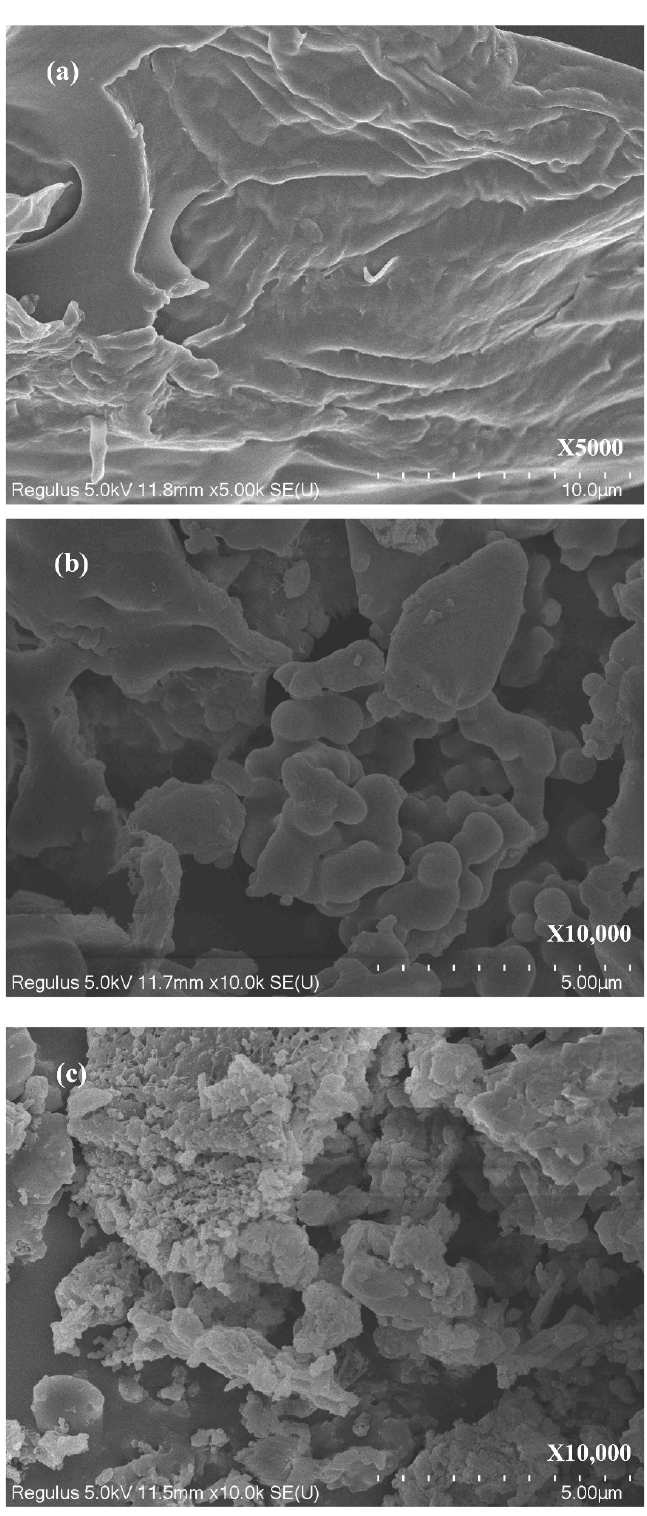
Figure 3. SEM images of PP and HC products. ( a ) raw PP, ( b ) HC obtained at 210 °C without catalyst, ( c ) HC obtained at 190 °C with CaO as the catalyst.